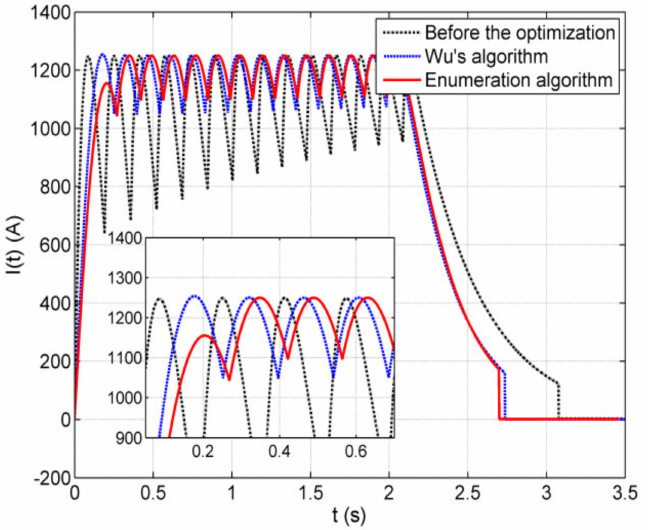
Figure 15. Charging current-time curves of the pulse capacitor of the two algorithms.